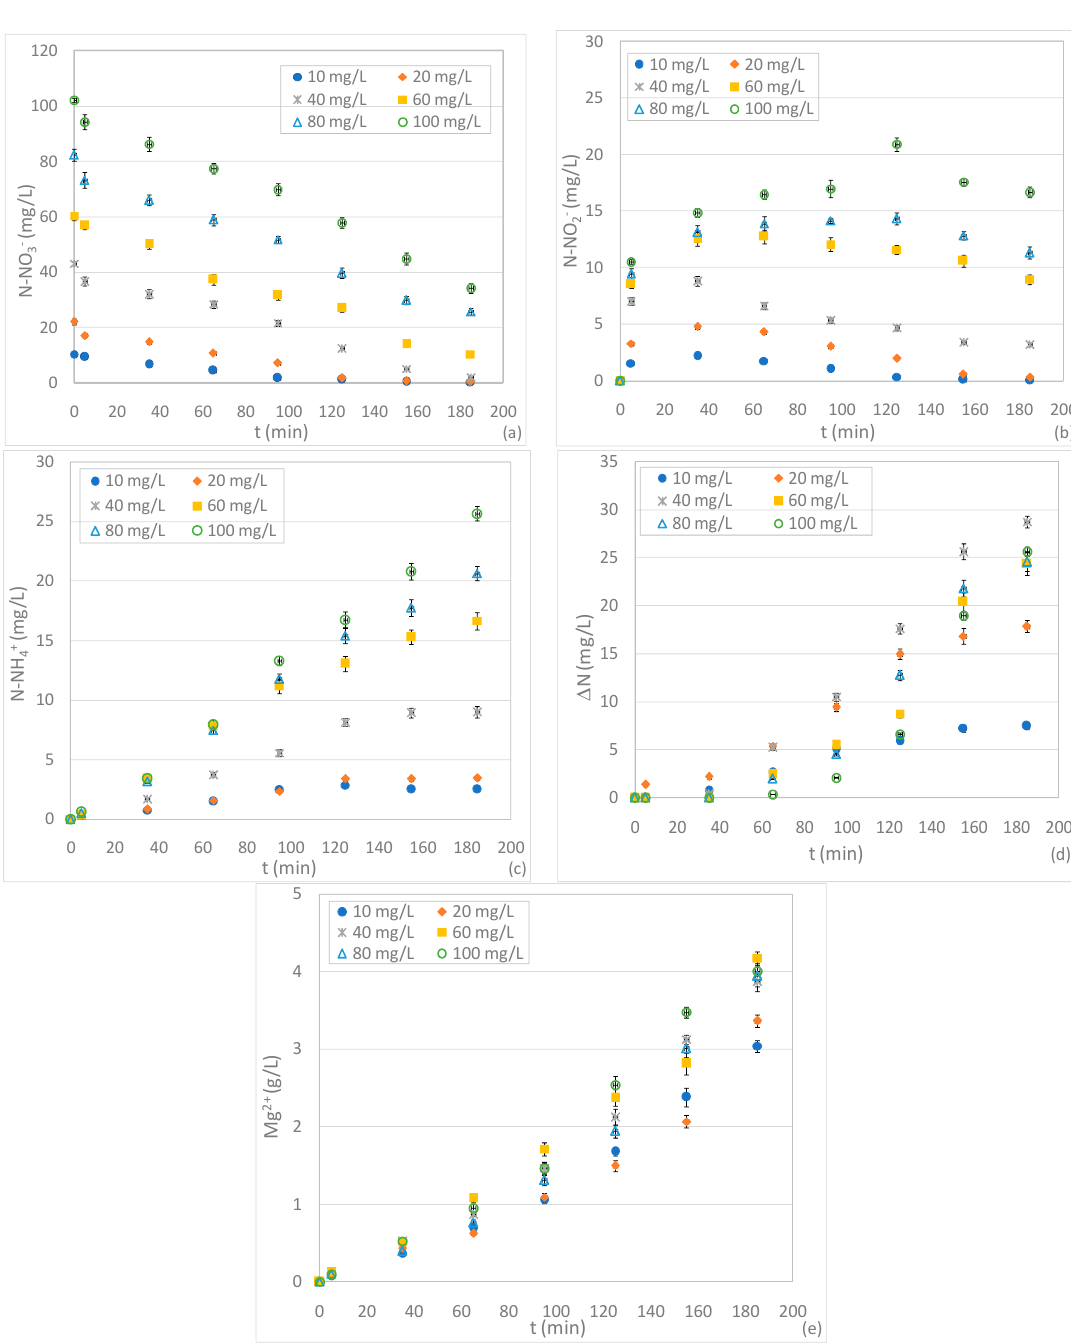
Figure 5. Concentrations of N-NO 3 − ( a ), N-NO 2 − ( b ), N-NH 4+ ( c ), Δ N ( d ) and Mg 2+ ( e ) during the tests carried out at pH 7, with 2 g of Mg 0 ,varying the initial N-NO 3 − concentration between 10 mg/L and 100 mg/L.